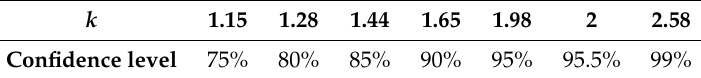
Table 1. The most used k values and their confidence